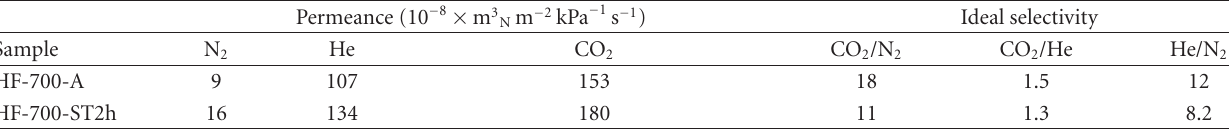
Table 5: E ff ect of soaking time on the permeance of carbon hollow